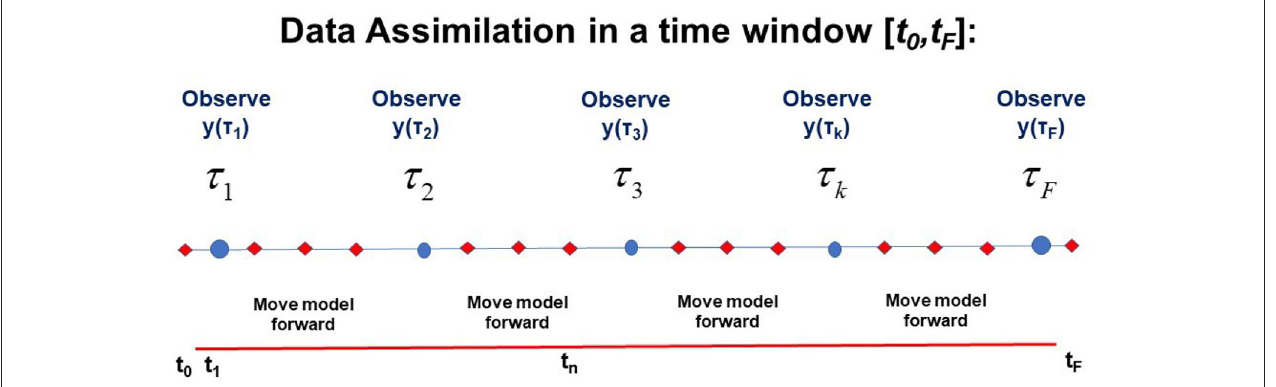
t t F in time during which L -dimensional observations y ( τ k ) are performed at observation times ≤ ≤ L . The path of the model X x (0), x (1),..., x ( n ),..., x ( N ) ≥ = { y 1 , y 2 ,..., y L ( y ) is also } = { }